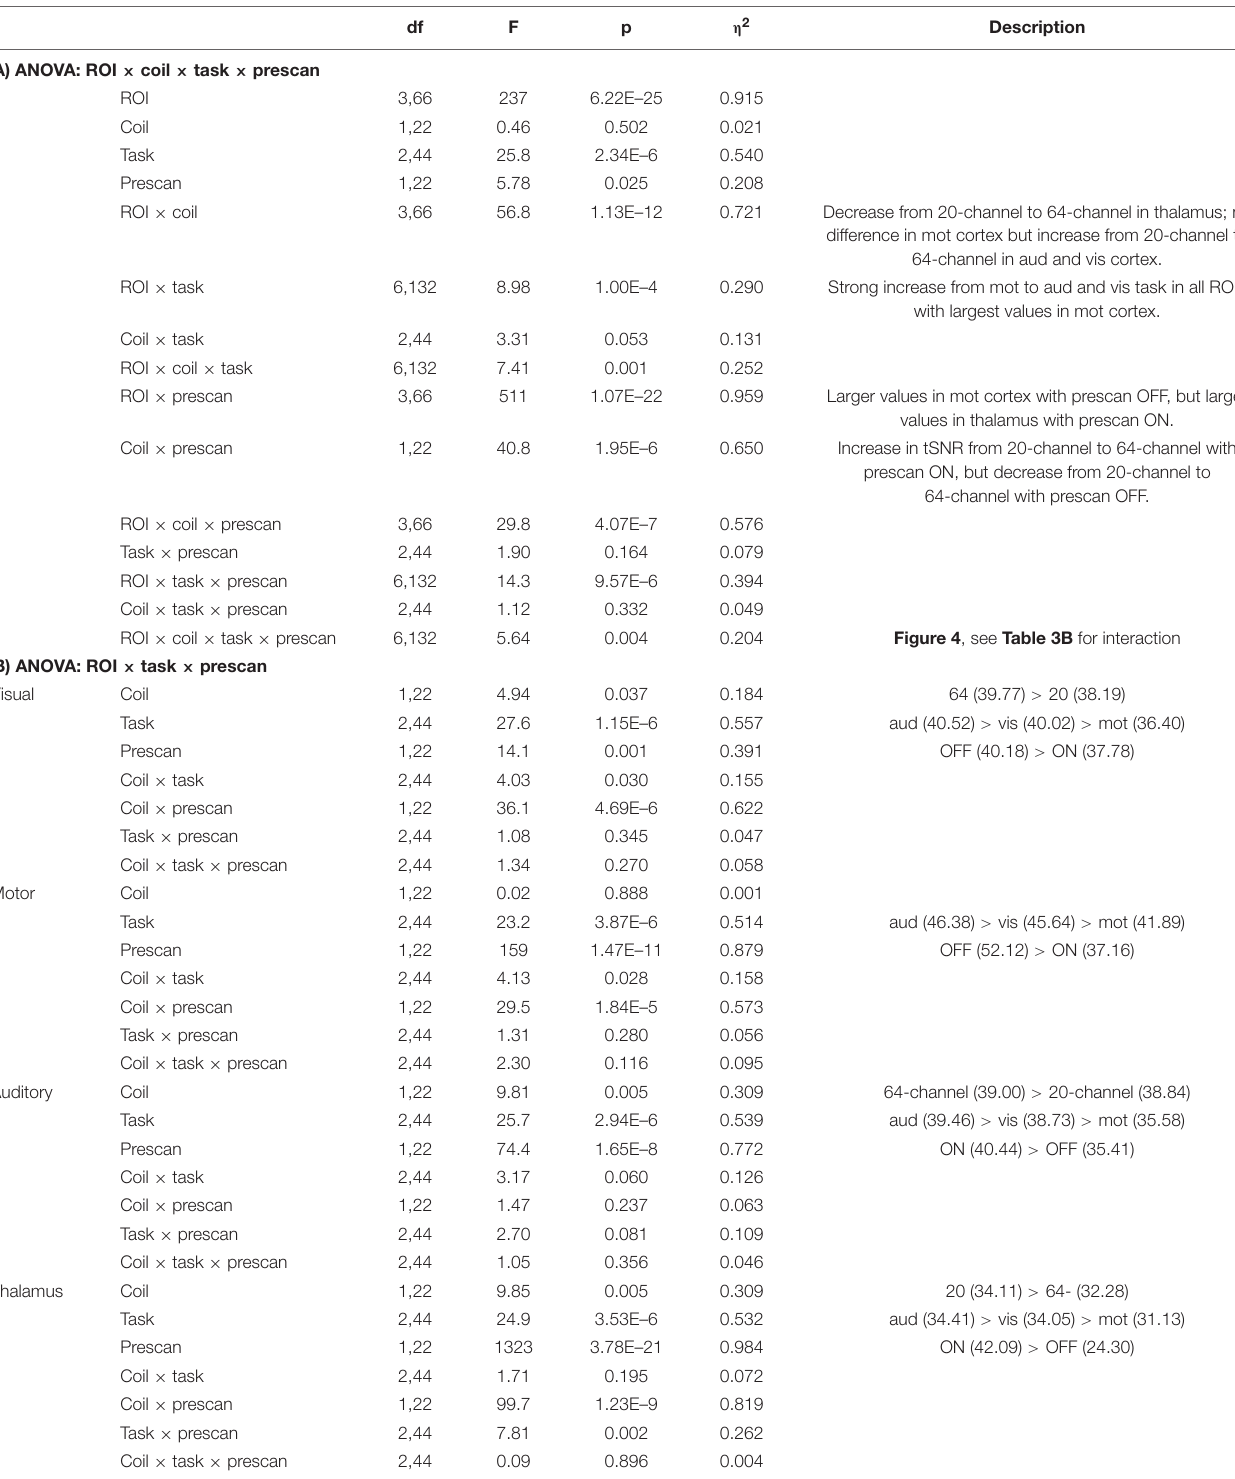
TABLE 3 | Results for tSNR